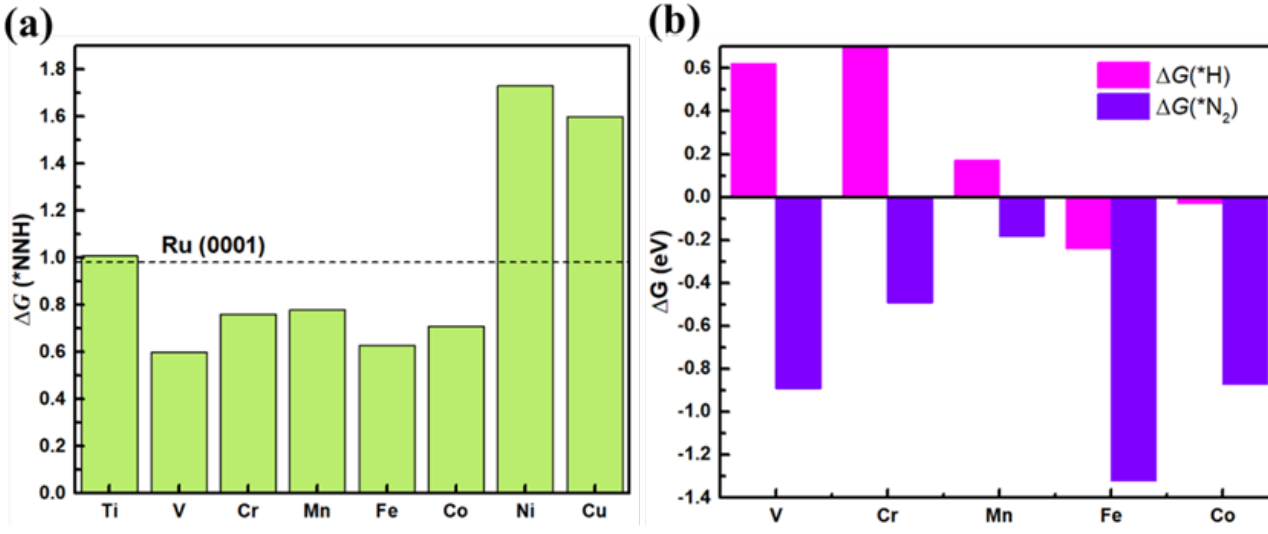
Figure 3. ( a ) The reaction free energy ΔG(*NNH), ( b ) absorption free energies of N 2 molecules ΔG(*N 2 ) and H atoms ΔG(*H) on the TM@g-C 3 N 4 (TM = V, Cr, Mn, Fe,